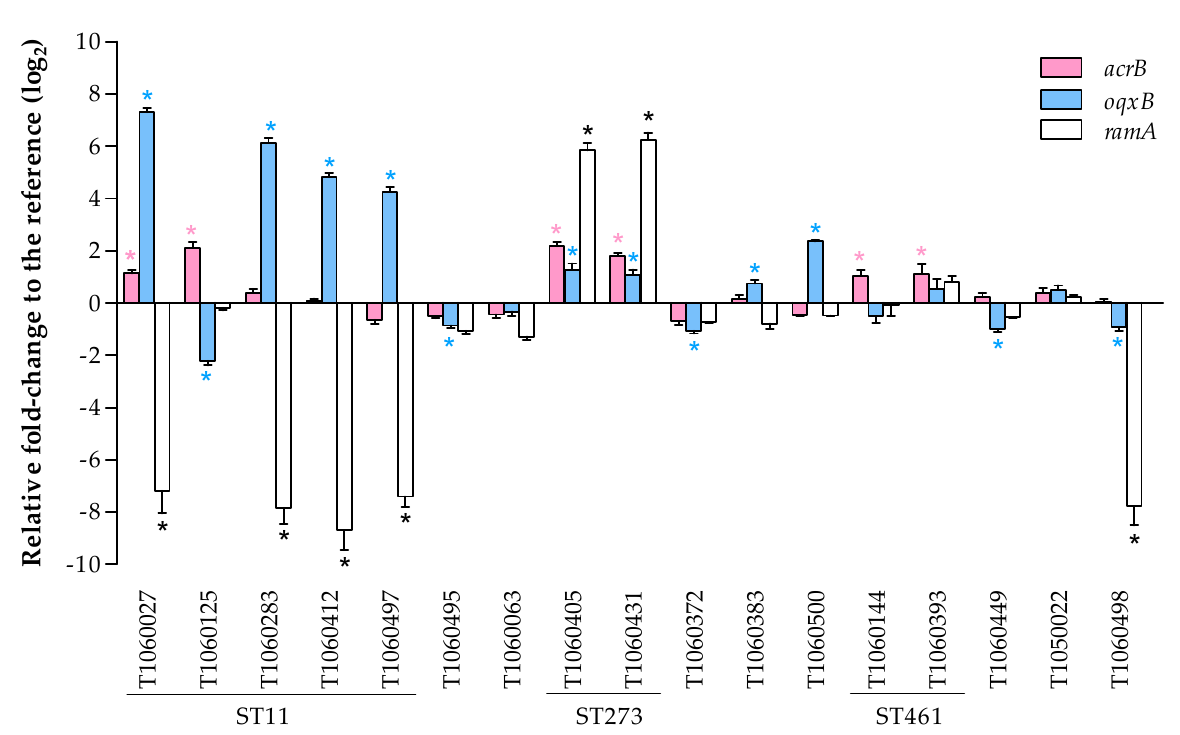
Figure 2. The relative gene expression of 2 efflux pump genes, acrB and oqxB , and a transcriptional activator, ramA, was measured by using quantitative reverse transcriptase PCR and compared with the expression of a housekeeping gene, rpoB . The bar height represents the mean relative fold-change relative to the reference strain, K. pneumoniae BCRC 13883, in triplicate. The error bar represents the standard error with a 95% confidence interval compared to the reference strain. The asterisk (*) indicates a significant difference with p ≤ 0.05.